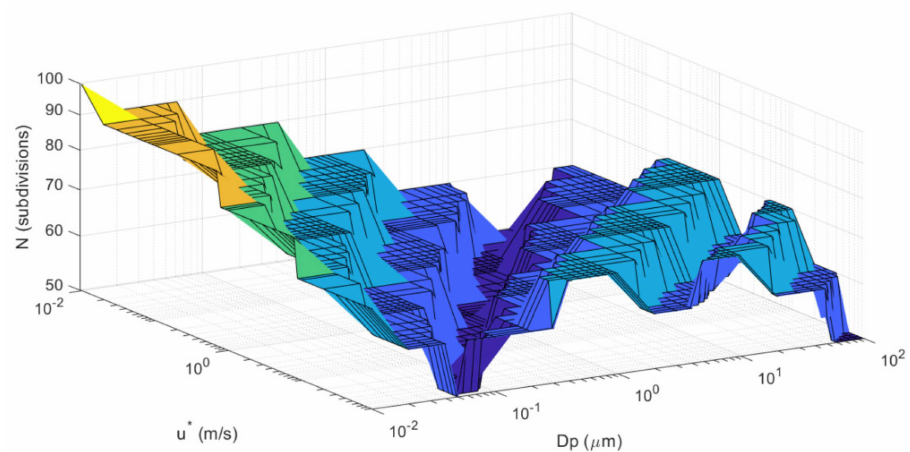
Figure 4. Appropriate number of subdivisions N for each pair of D p (10 nm–100 µ m) and u* (0.01–100 m/s).